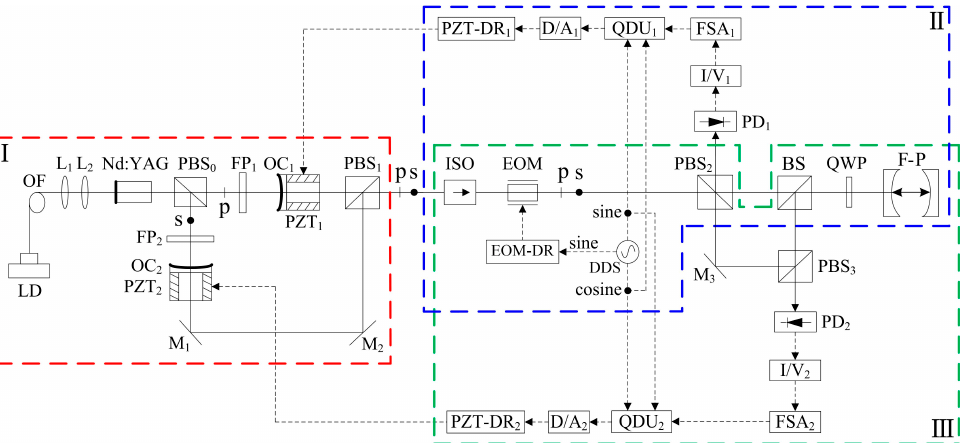
Figure 42. Schematic diagram of the frequency-difference-stabilizing system for the TCDFL using the single-modulator QD-PDH frequency-stabilizing method [44] . LD: laser diode; OF: optical fiber;